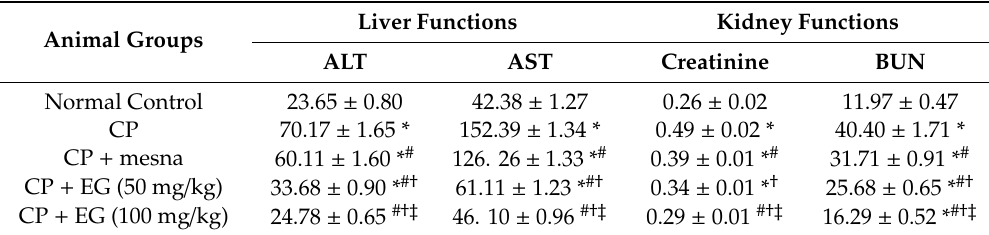
Table 2. Protective e ff ects of EG pretreatment on the serum markers against cyclophosphamide (CP)-induced hepato–renal toxicities in